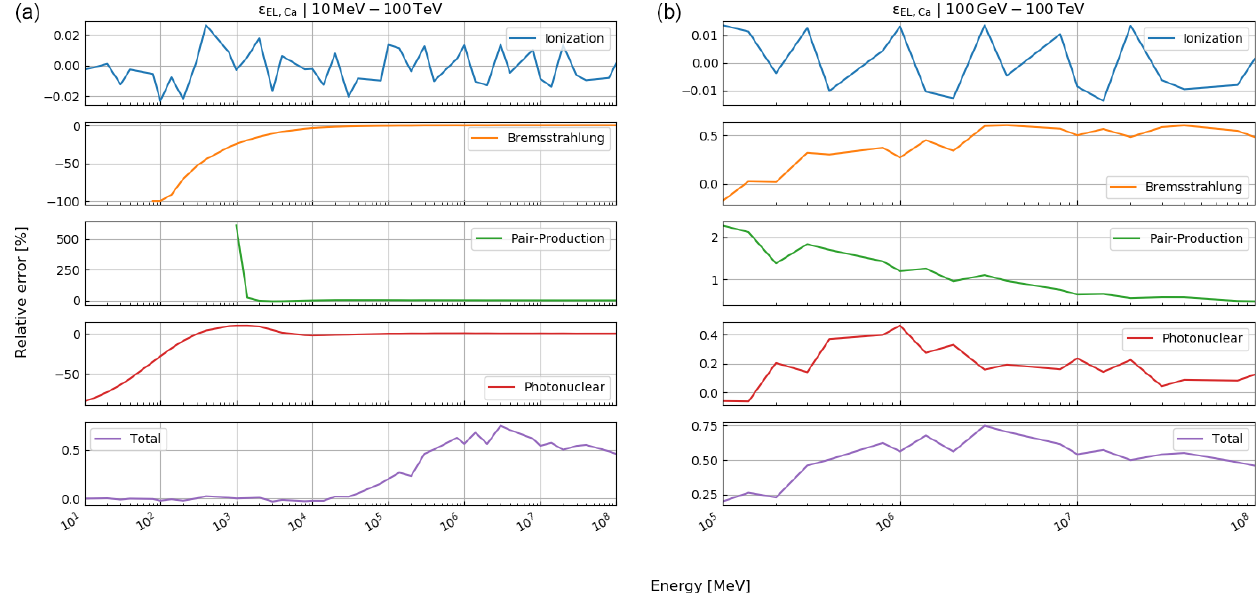
Figure E7. Relative error of our energy loss calculations compared to the tabulated values from Groom et al. (2001) for calcium in the energy ranges (a) 10MeV–100TeV and (b)